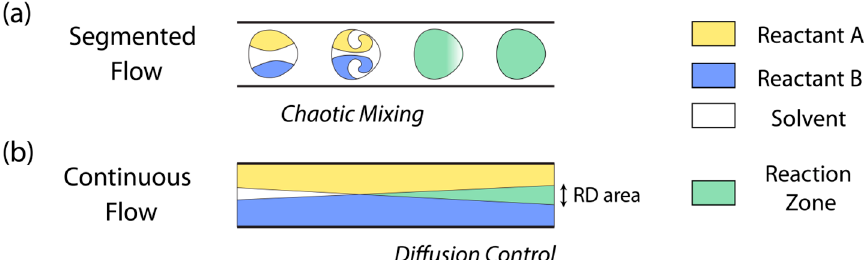
Figure 1. Comparison of reactants mixing in segmented ‐ and continuous ‐ flow microfluidic devices. As shown in this figure, in segmented ‐ flow devices ( a ), mixing is due to chaotic advection, whereas in continuous ‐ flow microfluidic devices ( b ), mixing of reactants is only accomplished through molecular diffusion. Note that the latter is a unique method for establishing an effective reaction–diffusion (RD) area, just like the ones present in nature. In the figure, the yellow and blue colors indicate reactants, the white color the pure solvent area, and in green is the reaction area.